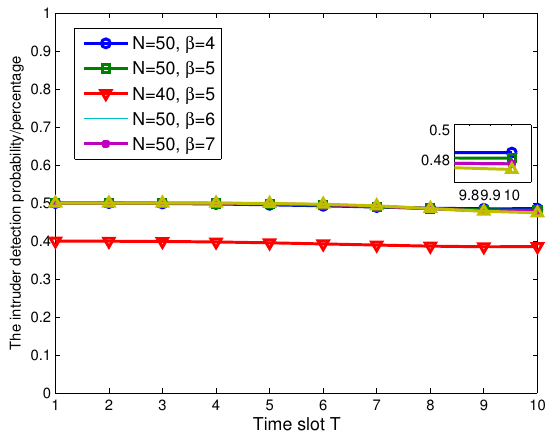
Figure 13. The intruder detection probability γ varies with T and β .